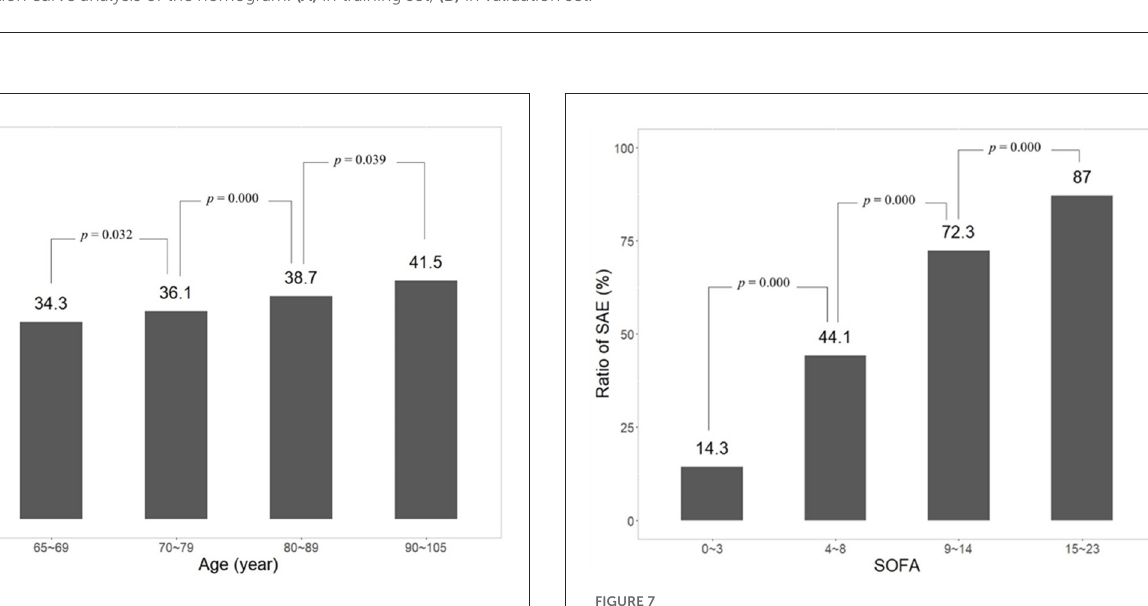
FIGURE6 Significant increase of SAE incident related to greater age.